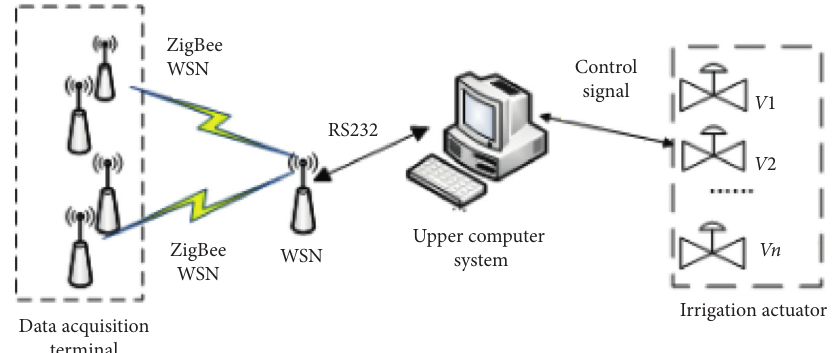
Figure 1: Schematic diagram of the intelligent irrigation